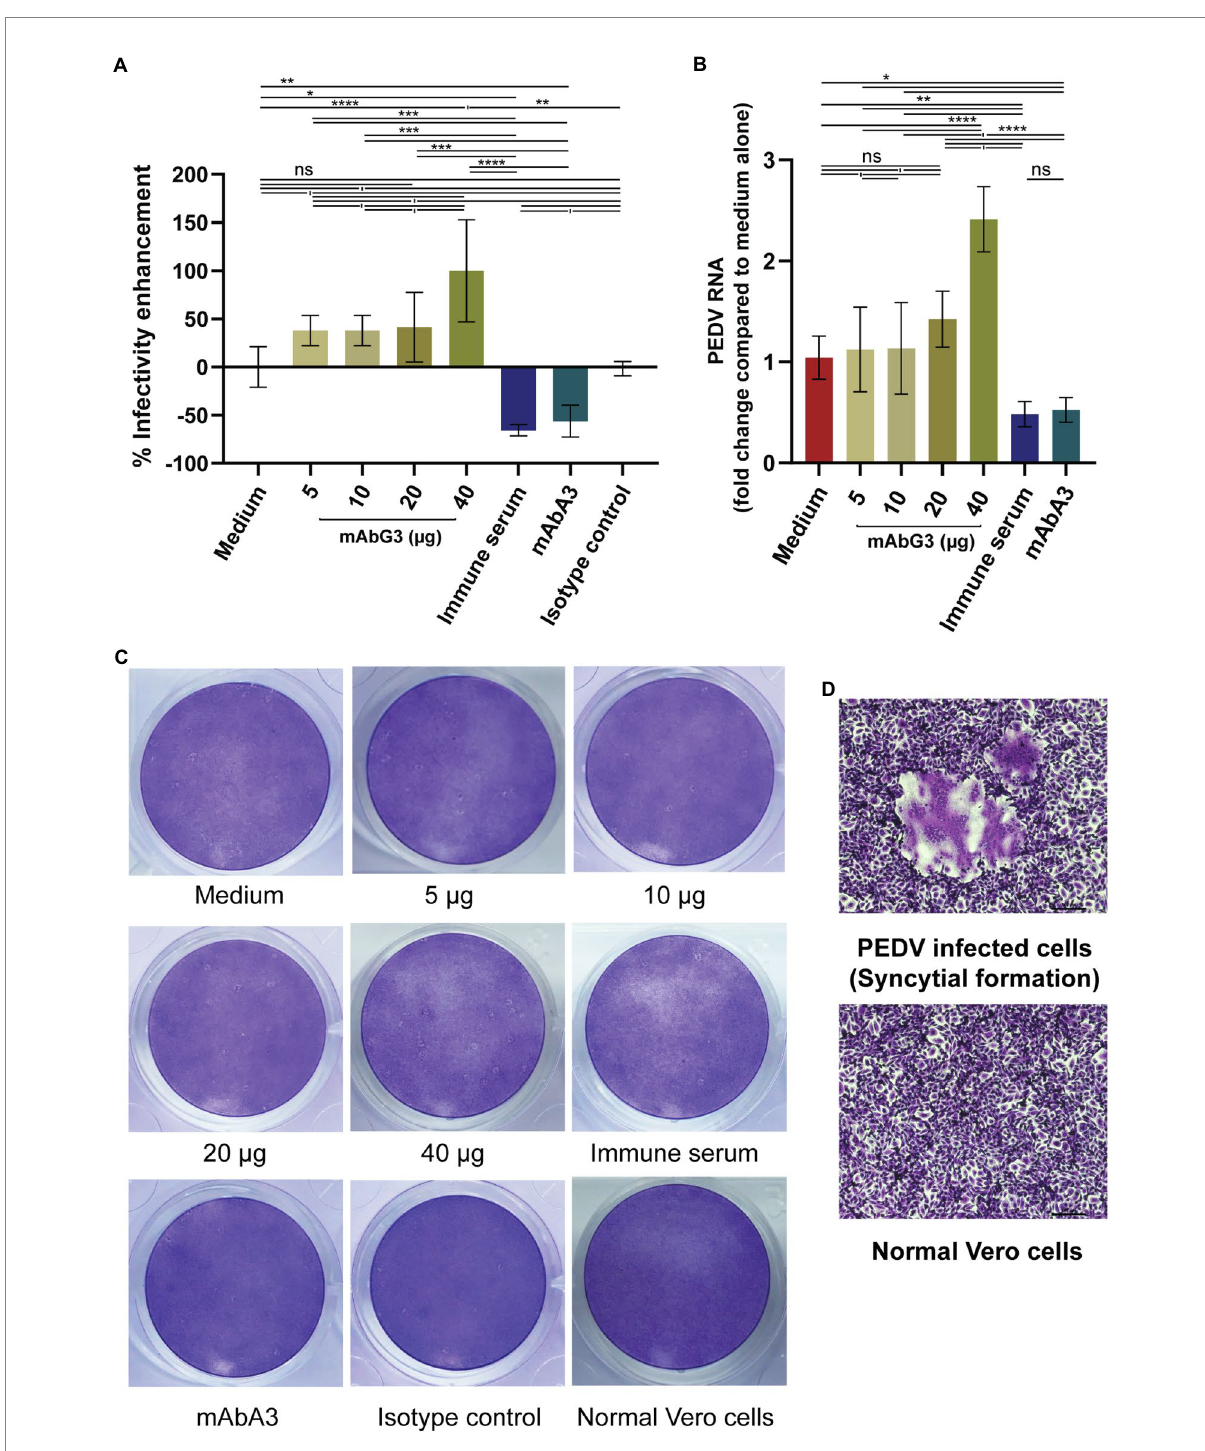
FIGURE 1 Enhancement of the PEDV infectivity mediated by the mAbG3. (A) The mAbG3 at the concentrations of 5, 10, 20, and 40 μ g was mixed with 100 pfu of PEDV GII strain P70 and incubated for 1 h before adding to the confluent monolayers of Vero cells. Immune serum to PEDV S1 subunit (1:100) and mAbA3 (40 μ g) served as positive neutralization controls, medium alone served as negative neutralization/enhancement control, and isotype- matched IgG1-kappa mAb served as irrelevant mAb control. After 1 h of incubation, the fluid in each well was removed; the cells were rinsed and covered with 2% CMC in DMEM supplemented with 2 μ g/ml of TPCK-treated trypsin. Two days post-infection, cells were fixed, and the number of syncytial formations was counted and calculated to % enhancement of PEDV infectivity compared to the medium alone. Data of each bar graph are presented as the mean and standard deviation of the % mAbG3-mediated enhancement of PEDV infectivity from triplicate wells of each treatment. (B) Results of qRT- PCR for determination of PEDV RNA recovered from different treatment groups. Y-axis, fold changes of PEDV RNA in different treatment groups compared to medium alone; X-axis, various treatment groups. By one-way ANOVA: ns, not significantly different; *, p < 0.05; **, p < 0.01; ***, p < 0.001; ****, p < 0.0001. (C) Examples of the PEDV-mediated Vero cell CPE of different treatments. (D) Appearance of syncytial formation of PEDV-infected Vero cells (upper panel) compared with normal Vero cells (lower panel) at ×100 magnification of a light